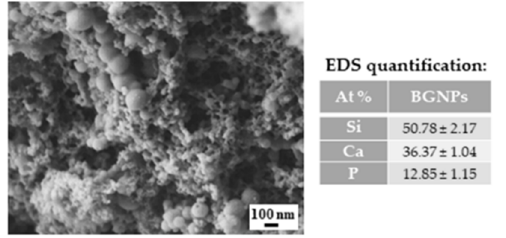
Figure 2. SEM image of the produced ternary BGNPs and EDS quantification (At. %) of the silica (Si), calcium (Ca), and phosphorous (P) presence in the BGNPs.